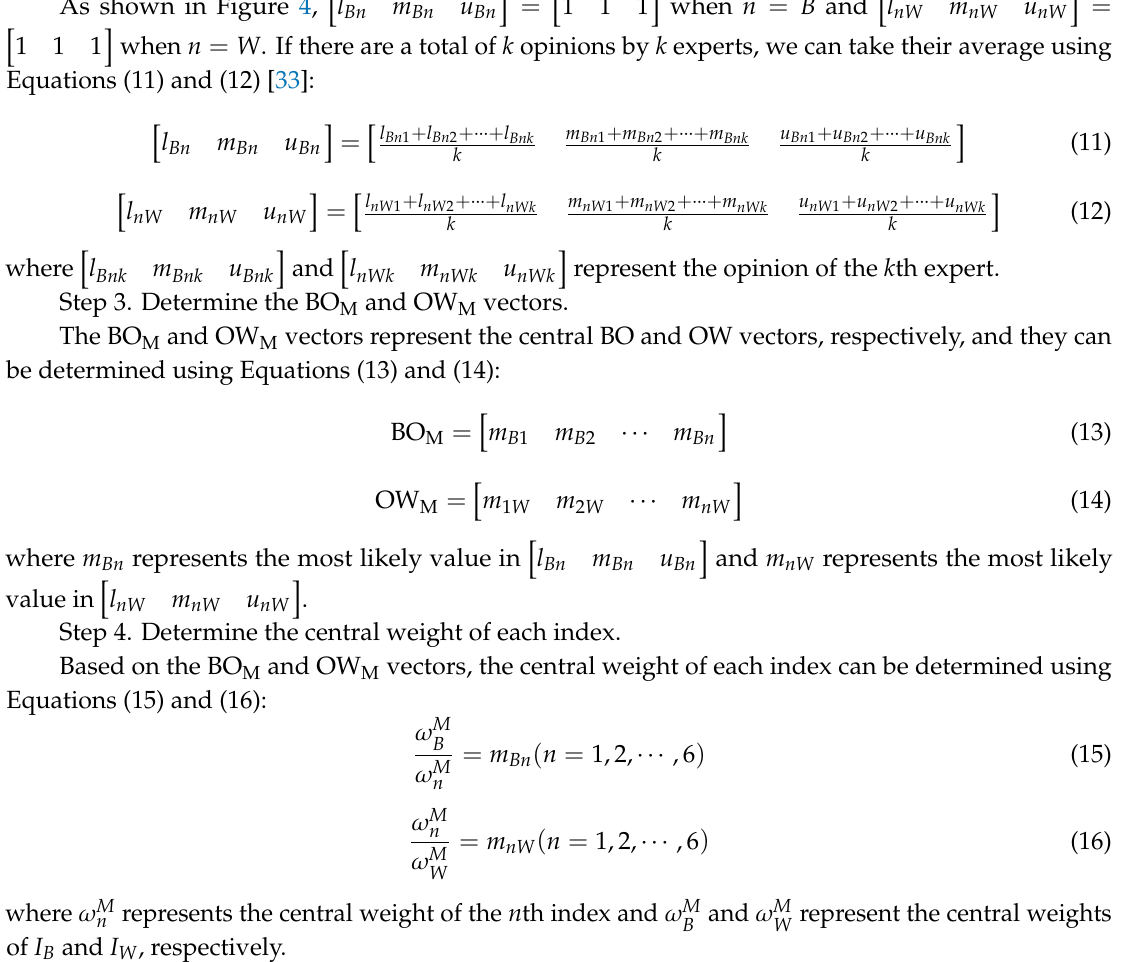
Figure 4. Membership functions of weight ratio.